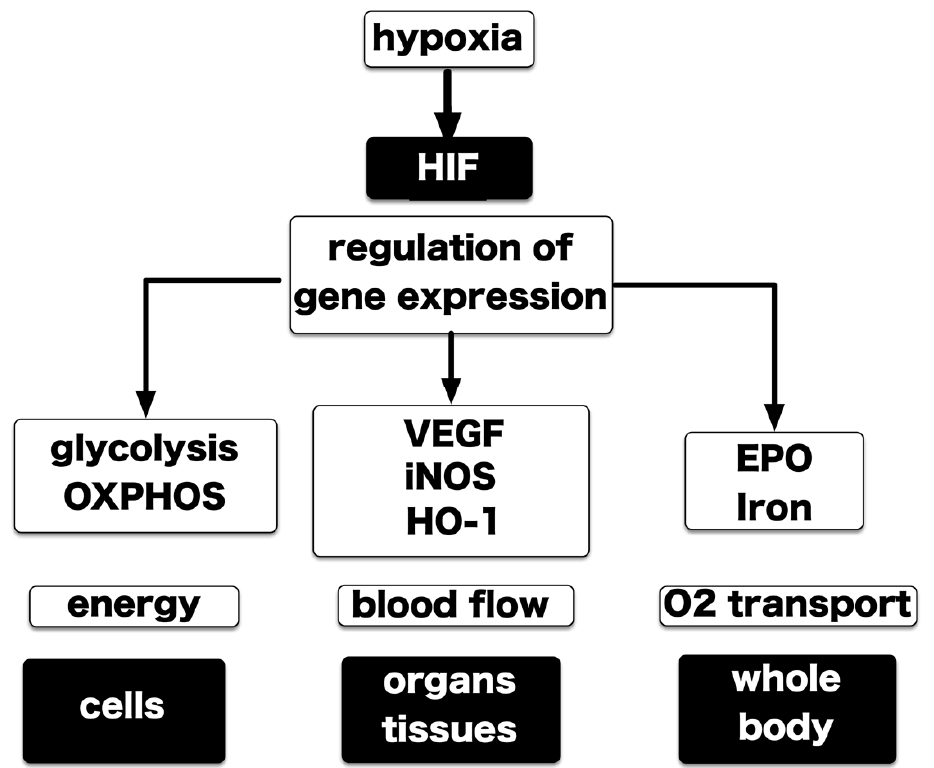
Figure 4. The network of transcription factors and hypoxic responses. Gene responses that depend on HIF-1 and HIF-2 (HIFs) are an important element of the response to low-oxygen by the living body and form an elaborate network. Responses are generated at the cellular, tissue, organ or whole-body level. At each level, a low oxygen response appears as the sum of the responses of individual cells. HIFs have been identified as a key transcription factor in this network. HIFs are present in all nucleated cells, and its activation depends on the partial pressure of oxygen to which cells are exposed. However, activation may be modified by factors specific to cells and tissues. iNOS: inducible nitric oxide synthase; HO-1: heme oxygenase 1.